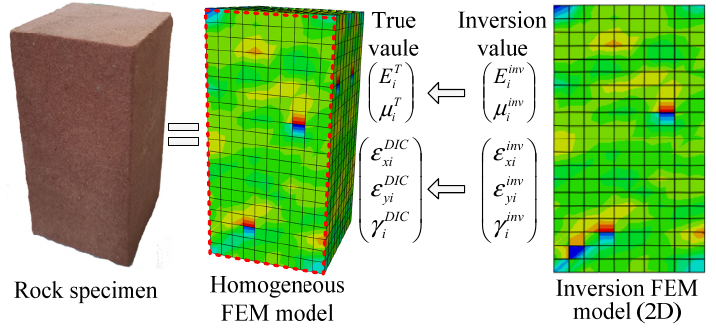
Figure 2. Verification thought of the inversion method.